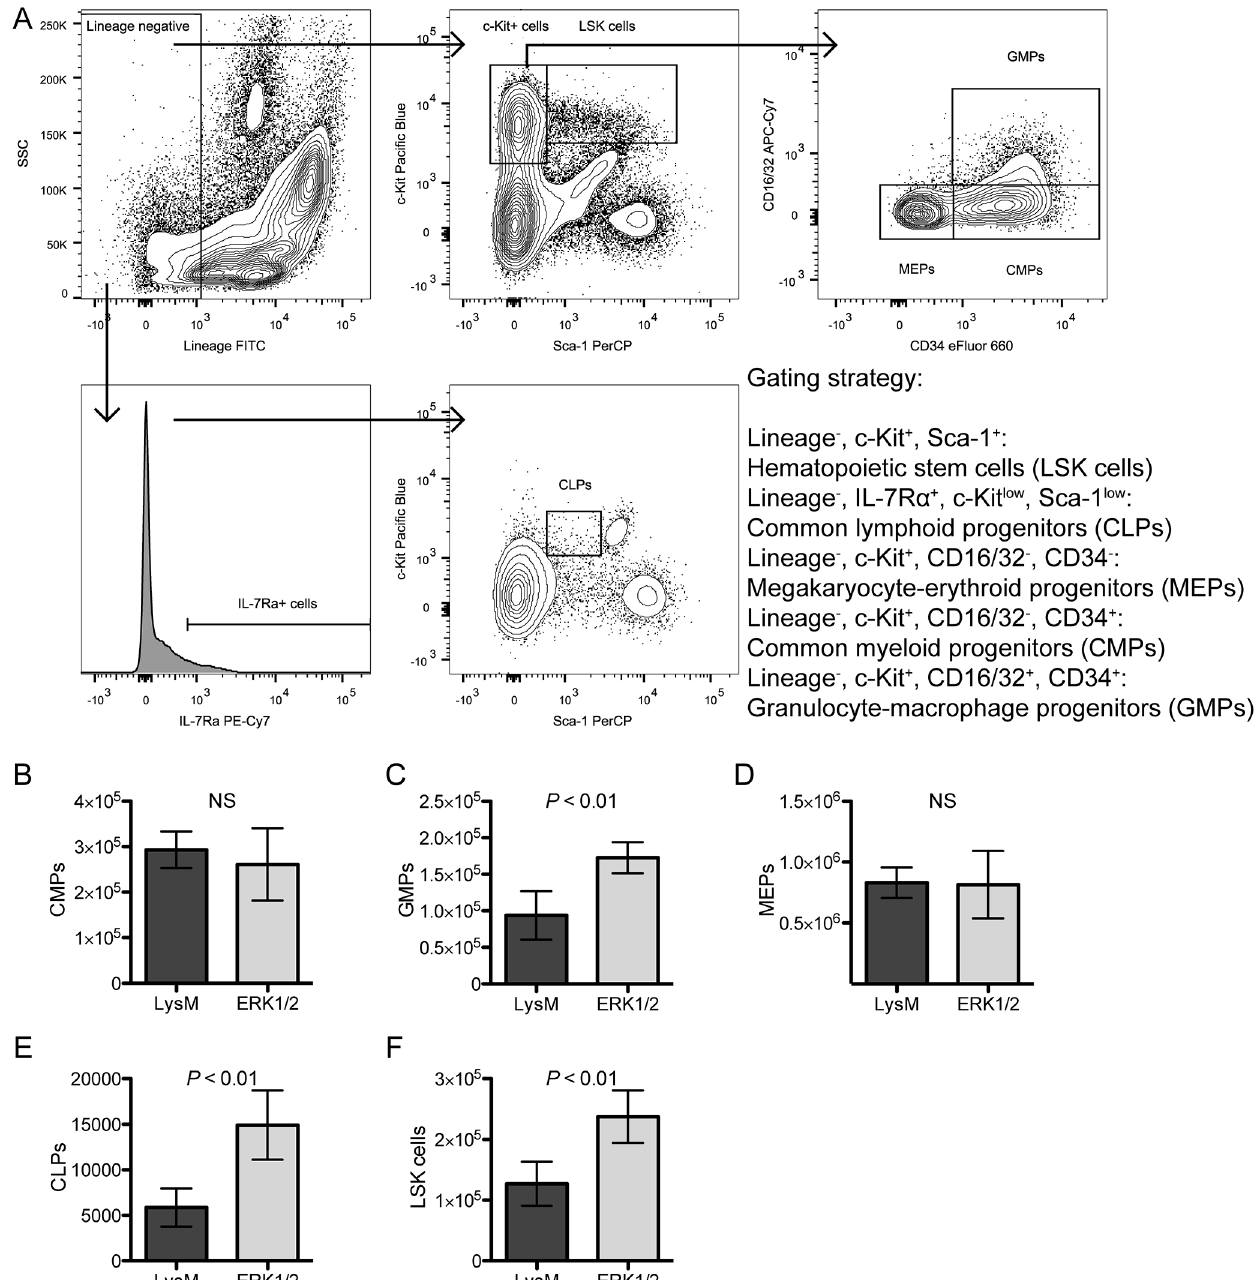
Fig 5. ERK1/2 mice have increased numbers of hematopoietic stem cells (LSK cells), common lymphoid progenitors, and granulocyte- macrophage progenitors on ex vivo flow cytometry analysis of progenitor populations. (A) Bone marrow cells from LysM and ERK1/2 mice (six of each) were counted using a hemacytometer and then analyzed by flow cytometry using the indicated gating strategy and the antibody panel described in Table 1. (B-F) Cell numbers from each population of immature hematopoietic cells were extrapolated from the total bone marrow cell counts and the percentage of each population following analysis in FlowJo. Data are represented as means ± standard deviations. Results are representative of two independent